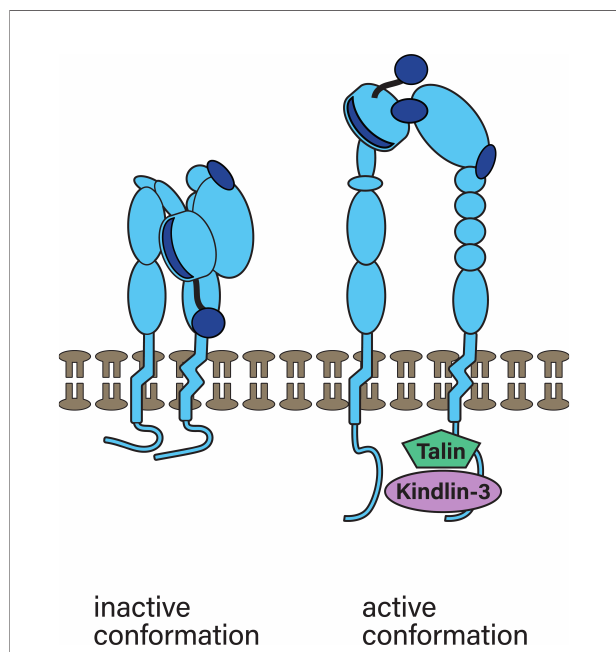
FIGURE 3 | Integrin conformation. In leukocytes traveling through the bloodstream, in absence of ligands, 90% of integrins are in the bent inactive conformation, depicted on the left. Inside-out signaling as a result of chemokine receptor/ligand and selectin/ligand binding during fast rolling results in talin and kindlin-3 binding to b chains which results in unbending and changing to the active conformation (right). The unbending results in ligand binding sites being